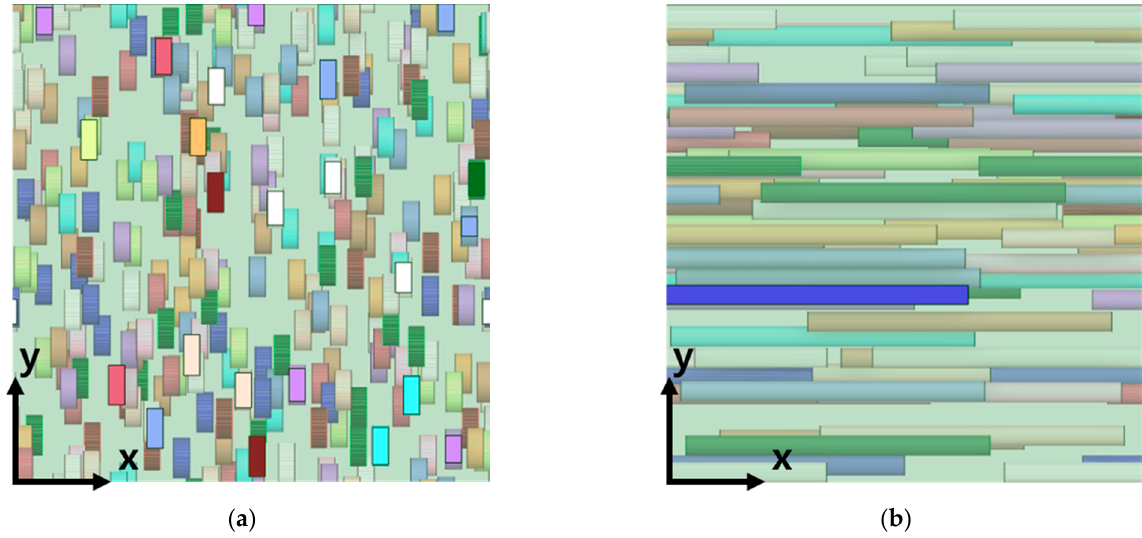
Figure 5. Elastic modulus (E 22 ) according to the UHMWPE aspect ratio.